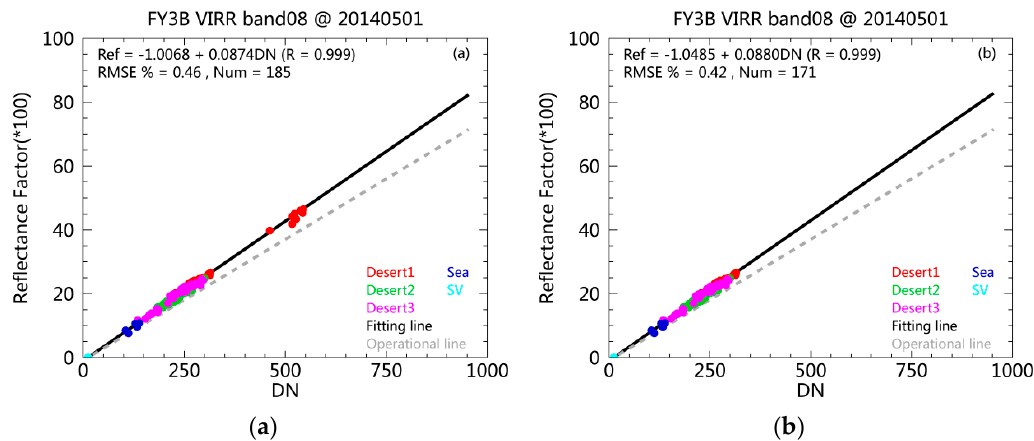
Figure 5. Examples of scatter plots of simulated TOA reflectance data versus FY-3B VIRR-measured digital number data for band 8 (505 nm) on 1 May 2014. ( a ) All 16 stable sites were used; ( b ) White Sands and Uyuni Salt Flats data were excluded.